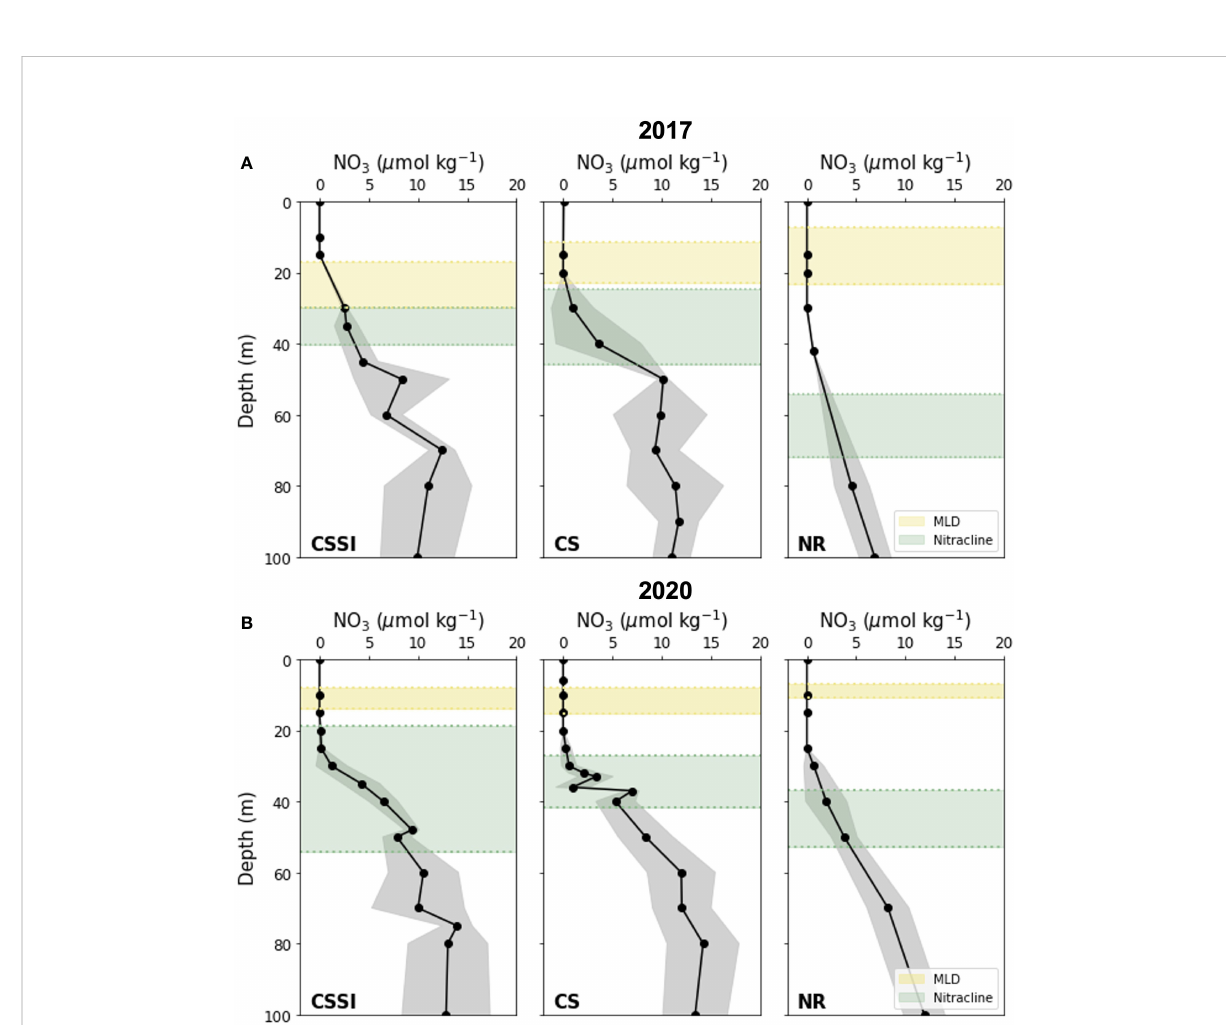
FIGURE 6 Vertical distribution of regional nitrate concentration in (A) 2017 and (B) 2020. Black markers denote average nitrate concentration; corresponding standard deviations are shaded grey. Regions enclosed within yellow and green dotted lines represent averages and standard deviations, respectively, of mixed layers and